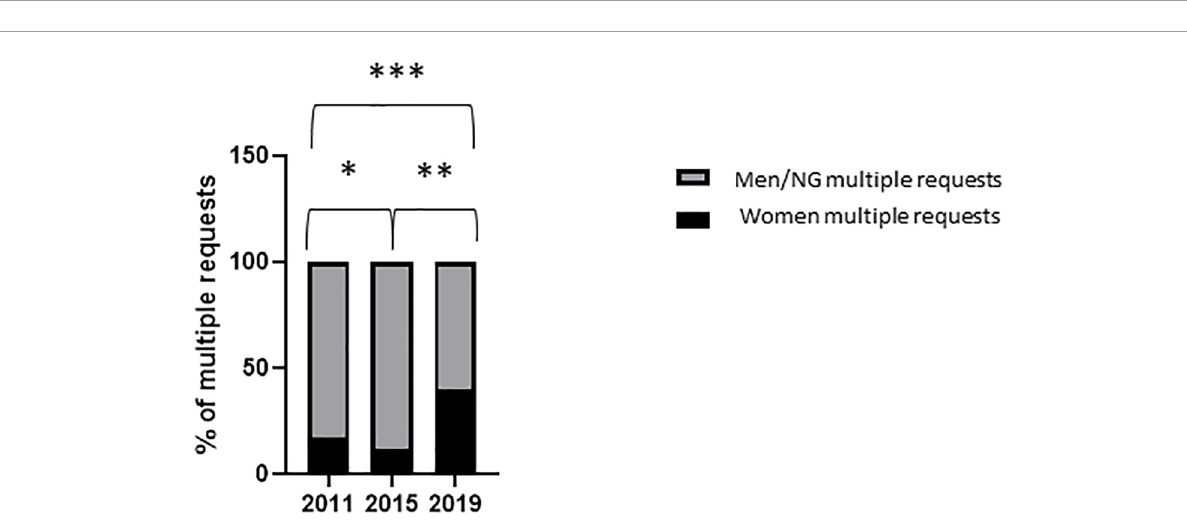
FIGURE5 Requests for multiple interventions to women. Proportion of women solicited at least twice for all type of sessions (major oral sessions and industry-led symposia) and all positions (speakers and moderators) during the three congresses. Variables are presented as percentages. After contingency analysis, variables were compared by Fisher’s exact test. A p -value < 0.025 was considered significant. ∗ p = 0.68; ∗∗ p = 0.01; ∗∗∗ p = 0.12. NG,